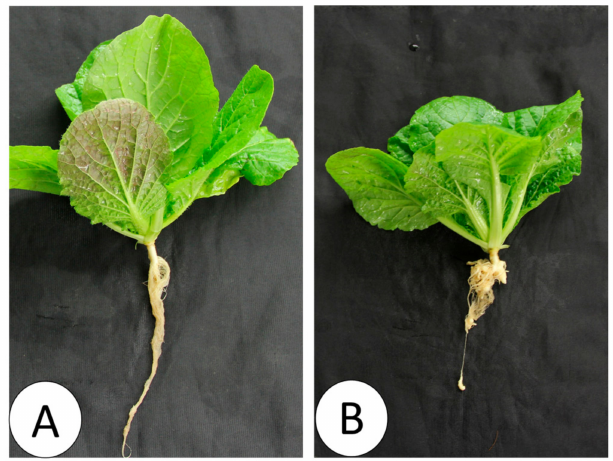
Figure 9. Nontreated ( A ) and Seosan-inoculated plants ( B ) of Chinese cabbage cultivar “Bullam-3-ho” at 35 days after inoculation of the “Seosan” isolate of P. brassicae